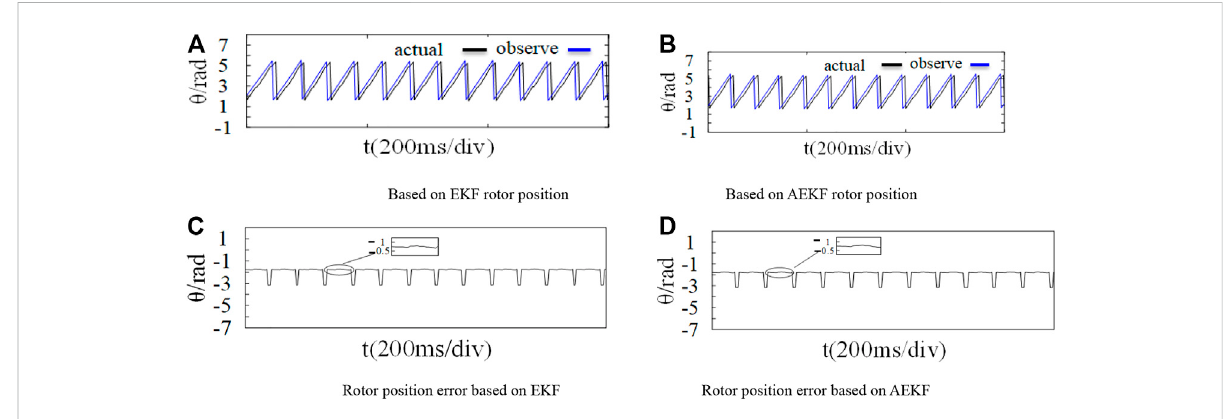
FIGURE 16 Rotor position waveform under internal interference. (A) Based on EKF rotor position. (B) Based on AEKF rotor position. (C) Rotor position error based on EKF. (D) Rotor position error based on